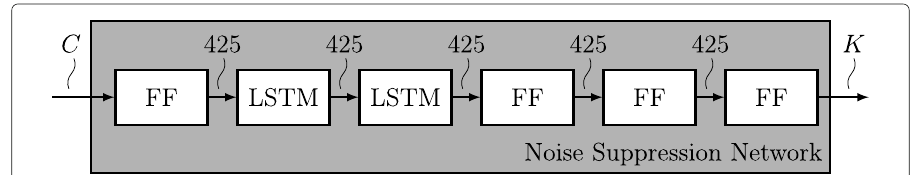
Fig. 2 Block diagram of the noisesuppressionnetwork utilizing LSTM and fully connected feedforward (FF) layers. The sizes of the one-dimensional feature representations inside the network are shown at the input and output of each layer. Except for the input features, these sizes are determined by the number of nodes in the preceding